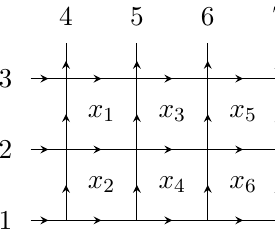
Figure 3 . Example web diagram for Gr(3 ;